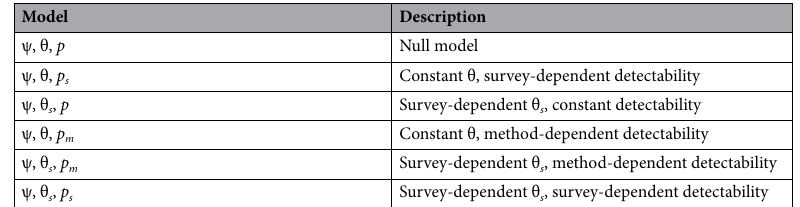
Table 2. Multi-method occupancy models fitted to estimate detectability of bird species in ponds located in the province of Murcia. In all cases the occupancy parameter ψ was modelled as constant. The small-scale occupancy parameters and the probabilities of detection were modelled as constant (θ, p ), as specific of the survey (θ s , p s ), and depending on the method ( p m